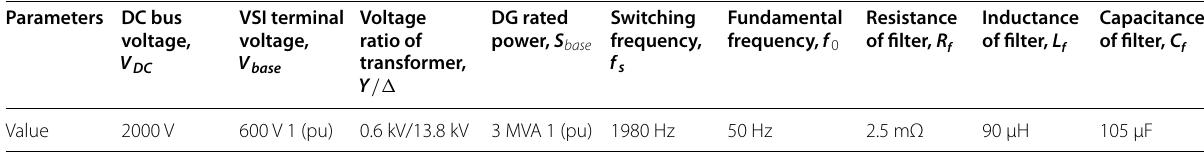
Table 2 Parameters of three‑phase MG Parameters DC bus